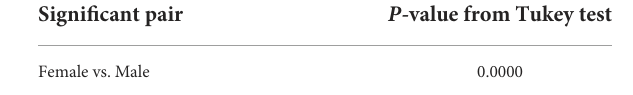
TABLE 8 Conversion from straightness group to curvature for multi-factor ANOVA (plus sign for outside and minus sign for inside).